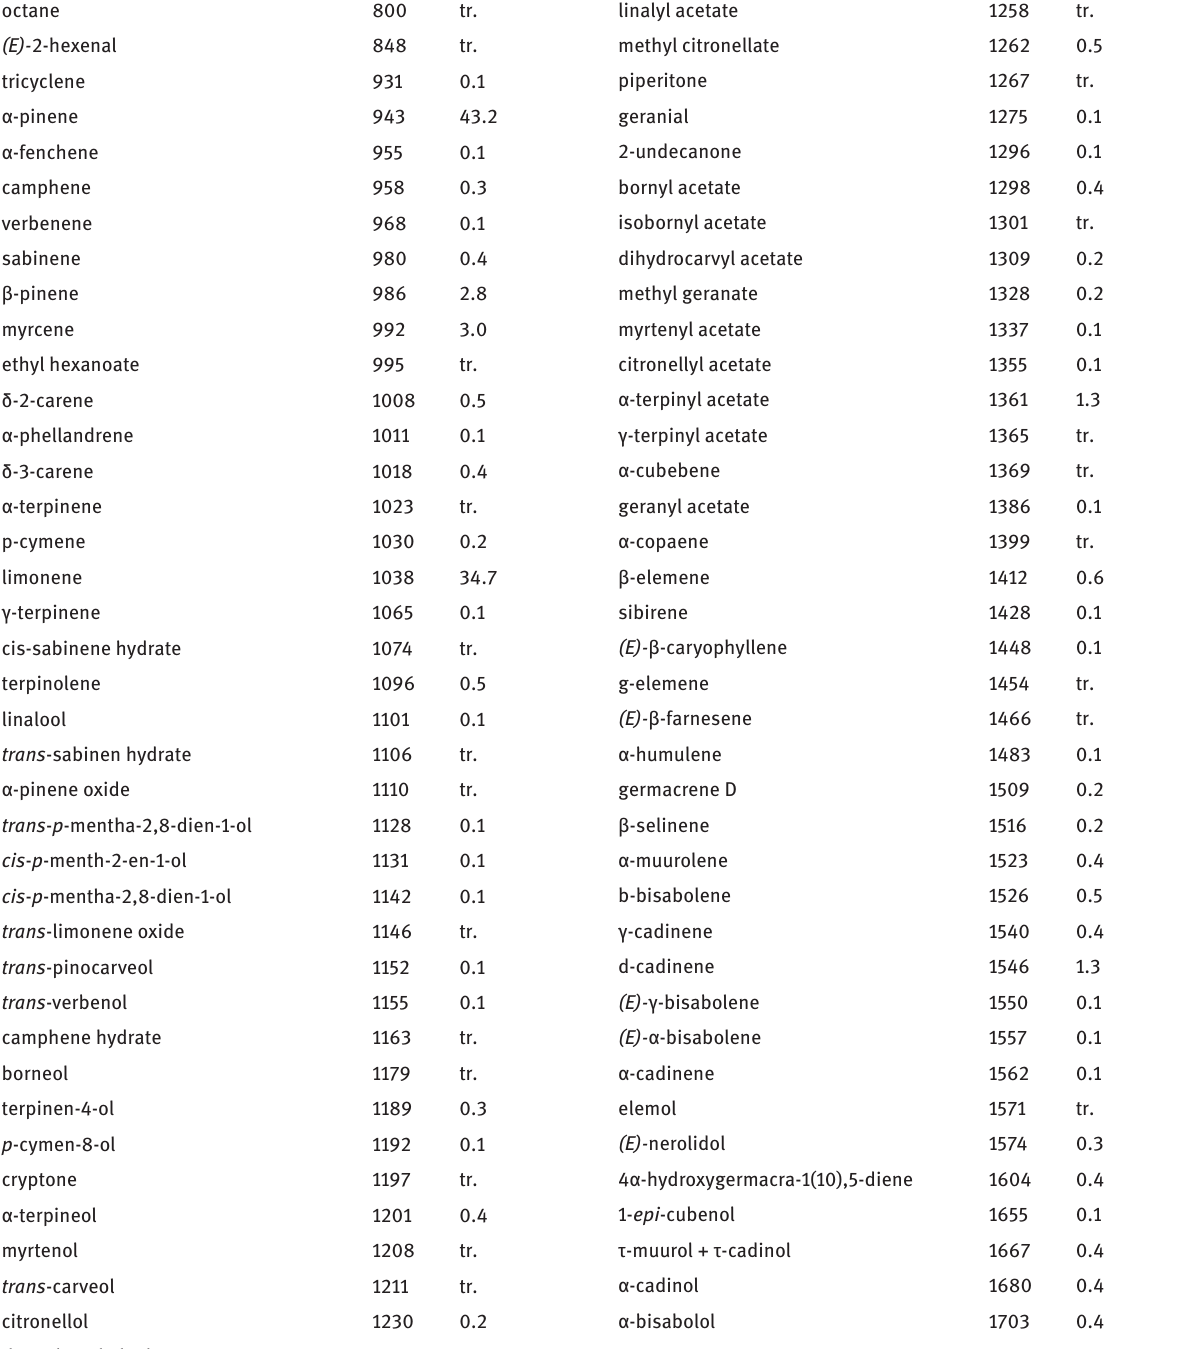
Table 2: Constituents identified in the essential oil of Juniperus communis analysed by GC-MS-FID. compounds RI